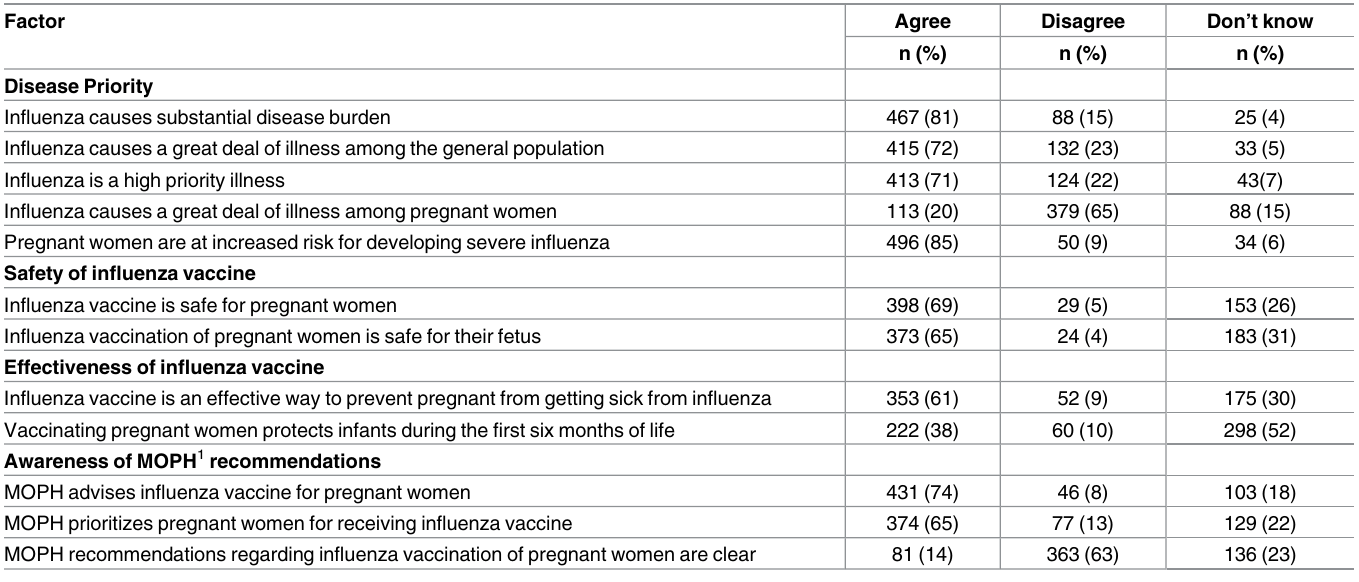
Table 2. Key perceptions of Thai physicians related to influenza vaccination (N = 580). Factor